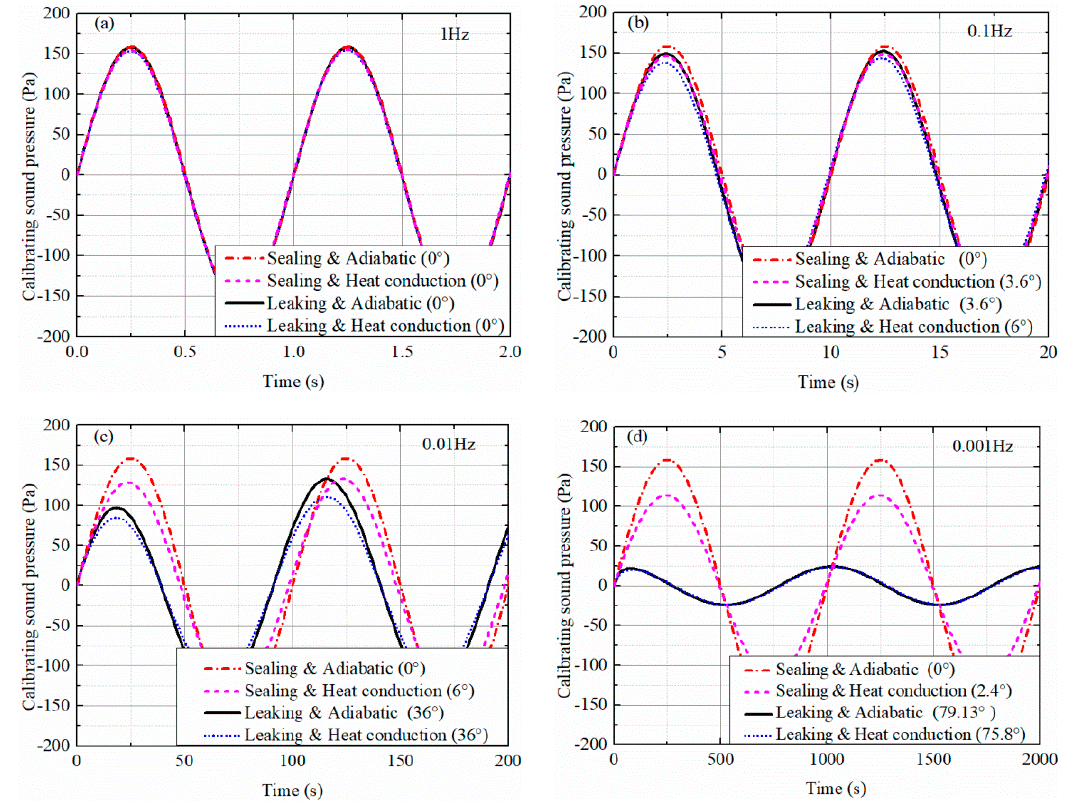
Figure 6. ( a ) Sound pressure waveforms of the calibrating sound pressure at 1 Hz. ( b ) Sound pressure waveforms of the calibrating sound pressure at 0.1 Hz. ( c ) Sound pressure waveforms of the calibrating sound pressure at 0.01 Hz. ( d ) Sound pressure waveforms of the calibrating sound pressure at 0.001 Hz.